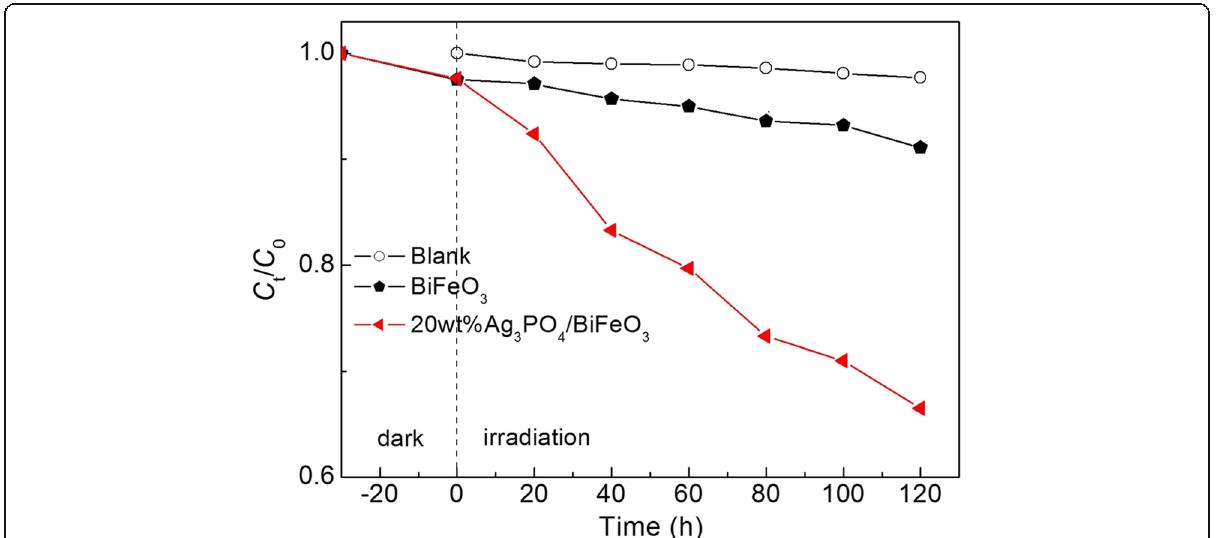
Fig. 6 Photocatalytic degradation of phenol over BiFeO 3 and 20wt%Ag 3 PO 4 /BiFeO 3 sample under visible-light irradiation, along with the blank and absorption experiment